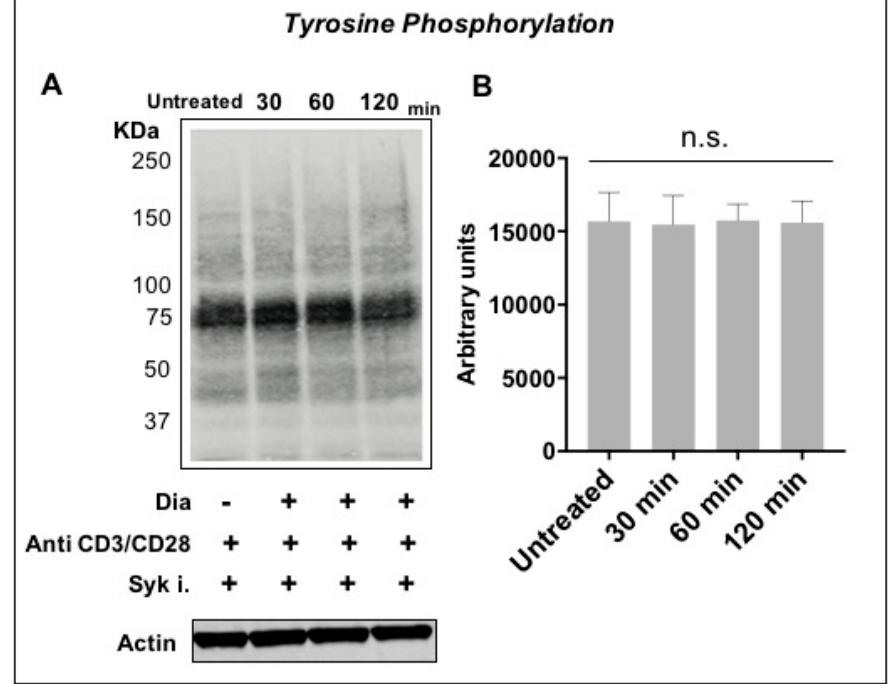
Figure 5. Role of Syk in T cells under oxidative condition. ( A ) Immunoblot of T cells treated with 0.3 mM diamide in the presence of Syk inhibitors 5 μ M (Syk i.), at different incubation times (0, 30, 60, 120 min). Beta-actin loading control is showed. ( B ) Quantification of tyrosine phosphorylation levels was performed by IR fluorescence detection (Odyssey, Licor, Lincoln, NE, USA) of antiphosphotyrosine Western blots and expressed as fluorescence arbitrary units (N = 3).